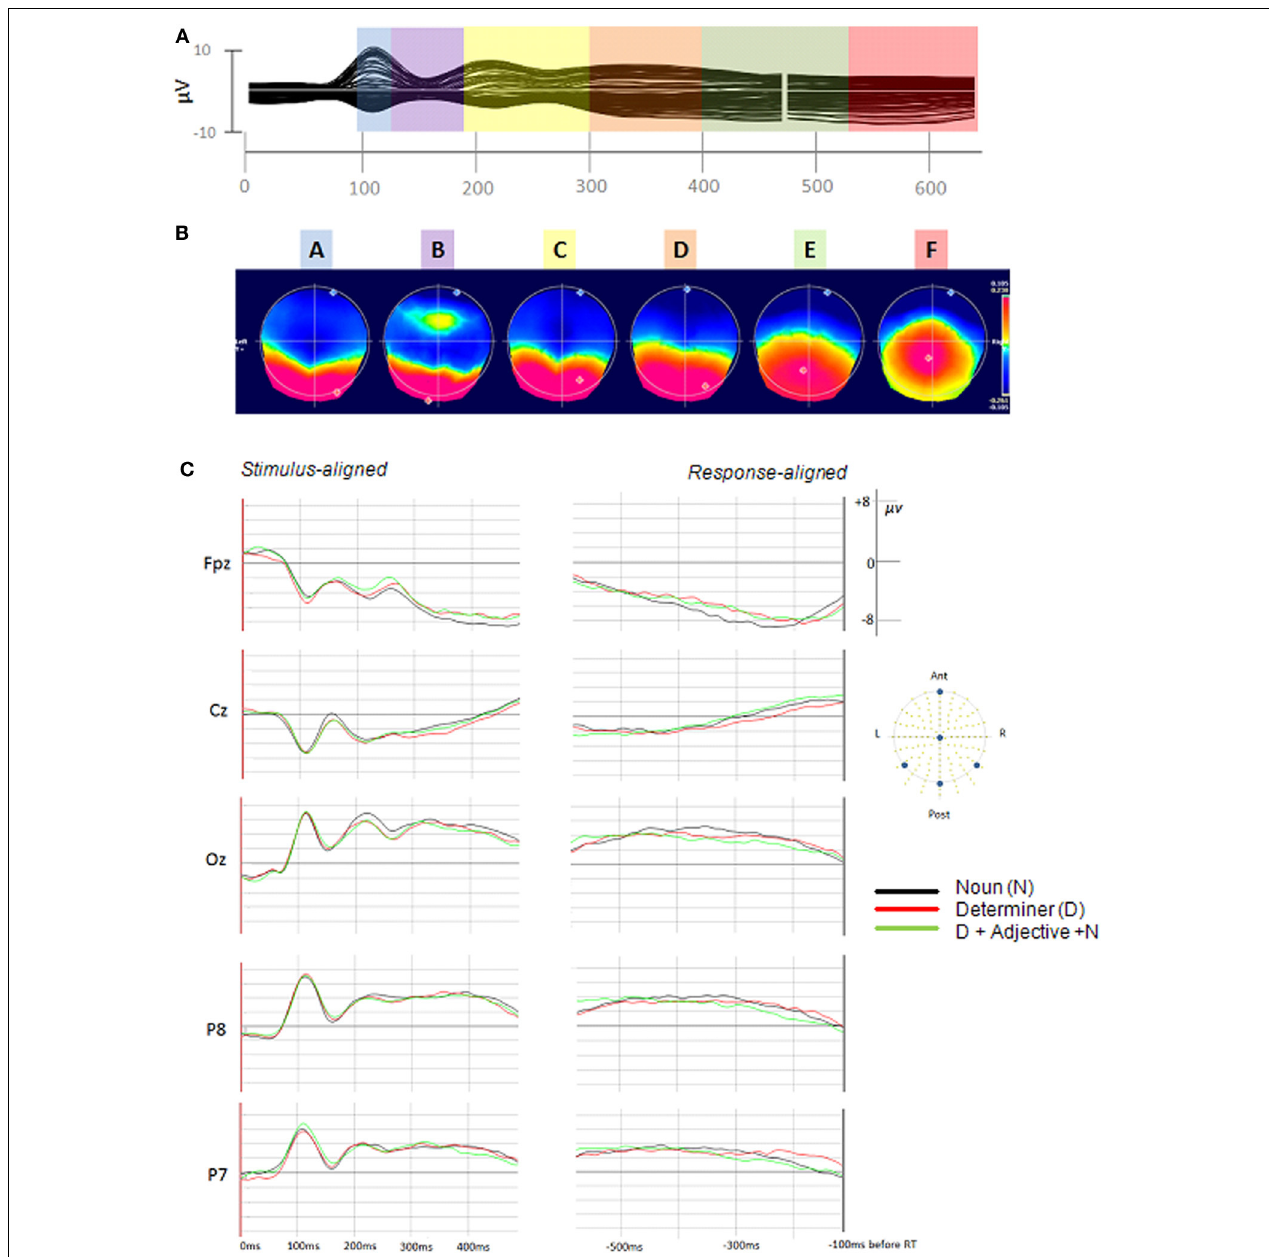
FIGURE 2 | (A) Stimulus-aligned and response-aligned grand-average ERP. The colors summarize the durations of the periods of stable global electrophysiological patterns (topographies), maps A, B, C, D, E, and F, respectively. (B) The corresponding topographic map templates are represented (positive values are in red and negative values are in